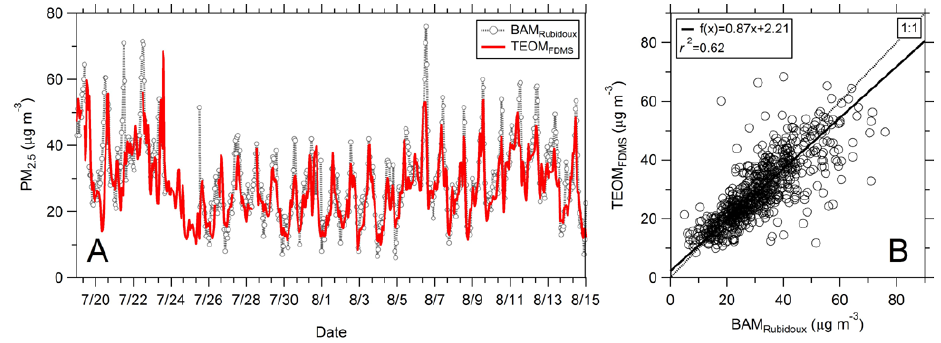
Fig. 1. Comparison of on- and off-site PM 2 . 5 mass concentrations: (a) time series and (b) scatter plot. On-site measurements were obtained from the TEOM FDMS while off-site measurements were obtained by the Rubidoux